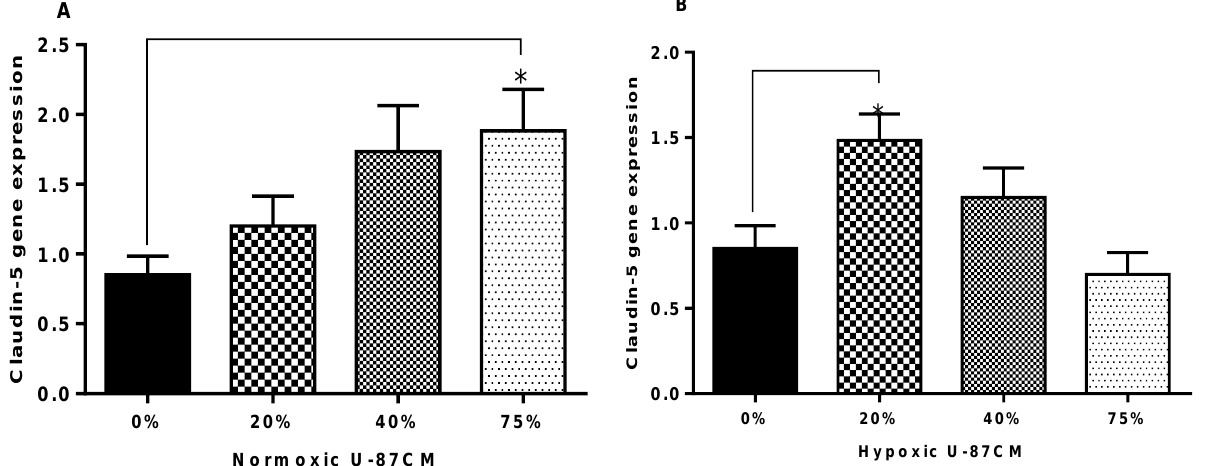
Figure 9. Gene expression level for Claudin-5 in bEnd.3 cells under the paracrine influence of glioblastoma U-87 cells. ( A ) Shows Claudin-5 gene expression in bEnd.3 cells after the exposure to selected concentrations of conditioned media derived from U-87 cells (U-87CM) under normoxic conditions (21% O 2 ) (* p < 0.03). ( B ) Represents Claudin-5 gene expression in bEnd.3 cells after the exposure to selected concentrations of U-87CM were generated under hypoxic conditions (5% O 2 ) (* p < 0.05), ( n = 4).